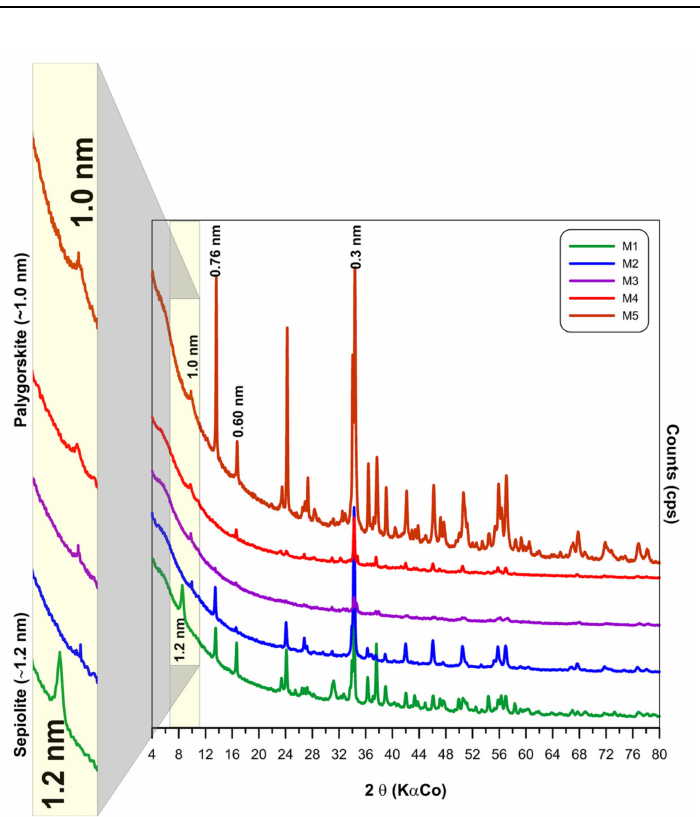
Figure 8. XRD patterns of the five measured samples (M1, M2, M3, M4 and M5). The samples were measured using a fine focus cobalt tube (K α Co radiation). The basal peaks with interplanar distance of 1.0 and 1.2 nm enlarged at the left of the figure are characteristic of palygorskite and sepiolite,